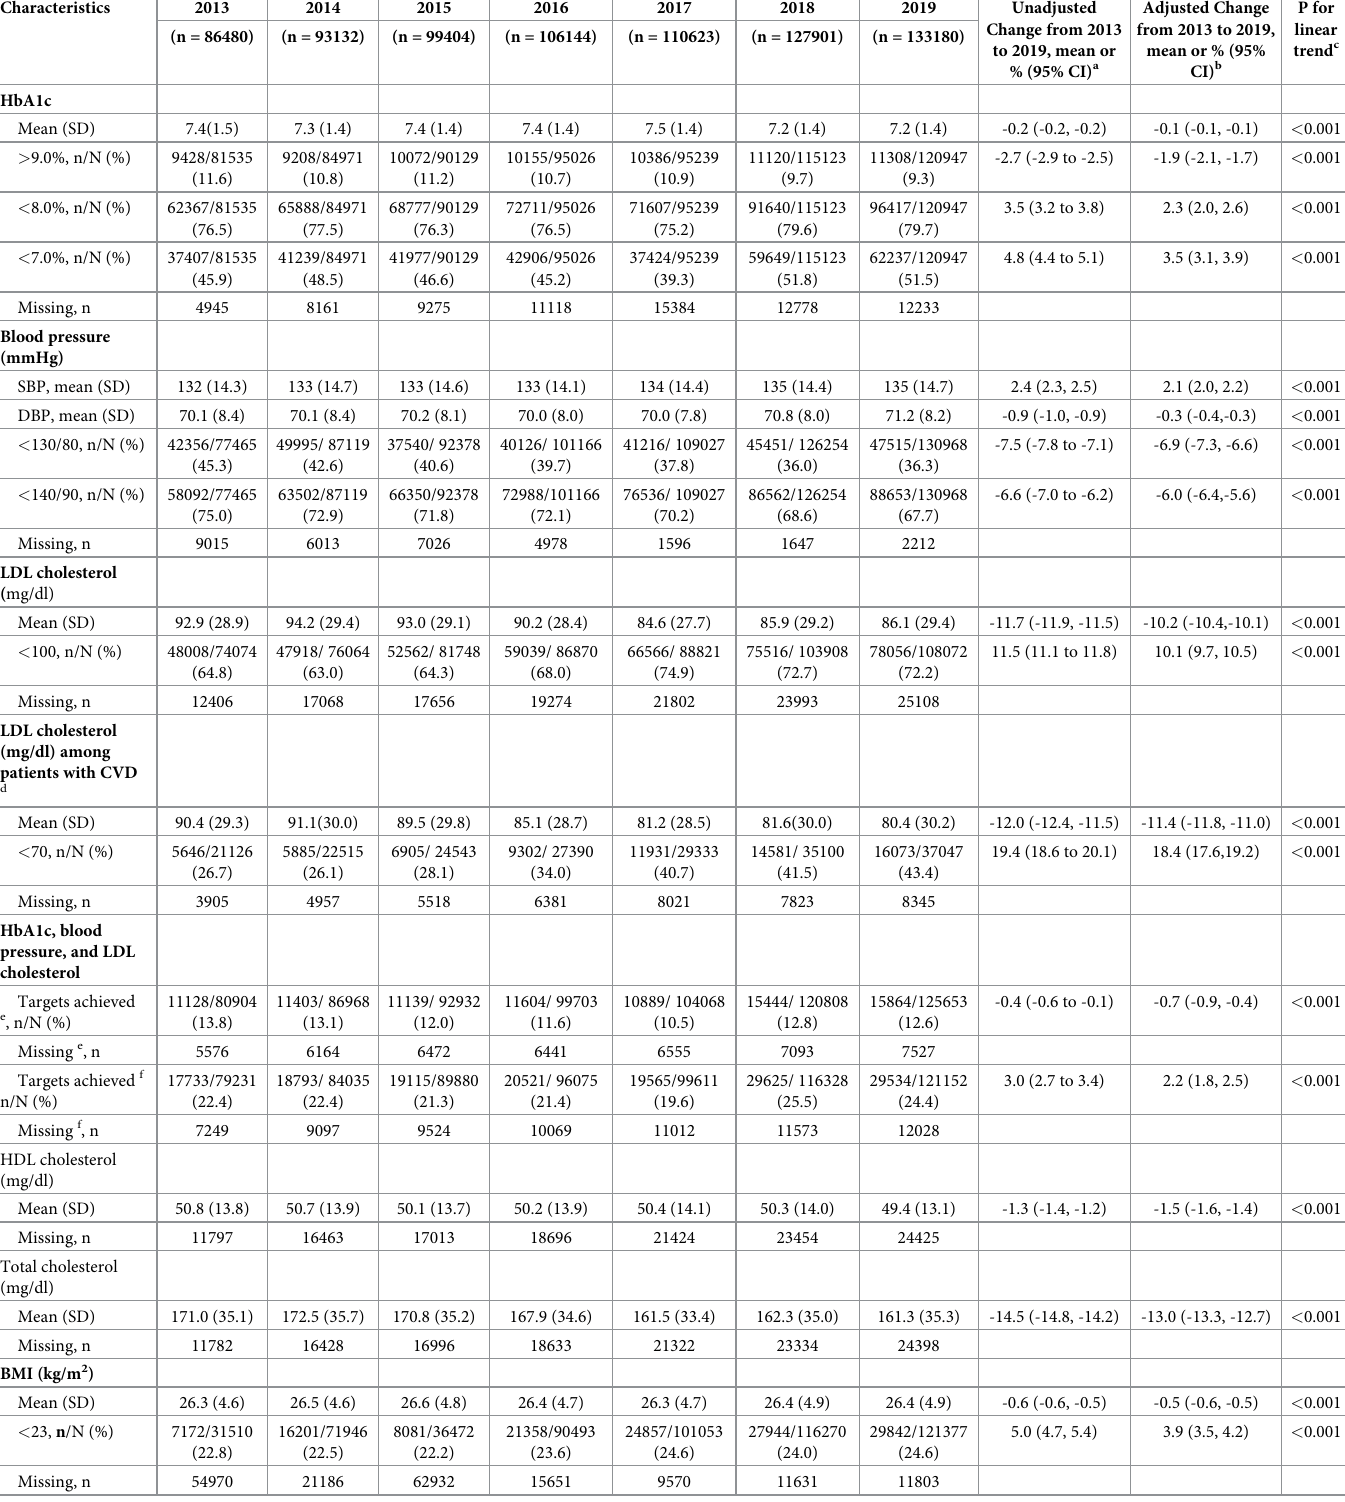
Table 2. Change in risk factor control and preventive care among patients with diabetes.